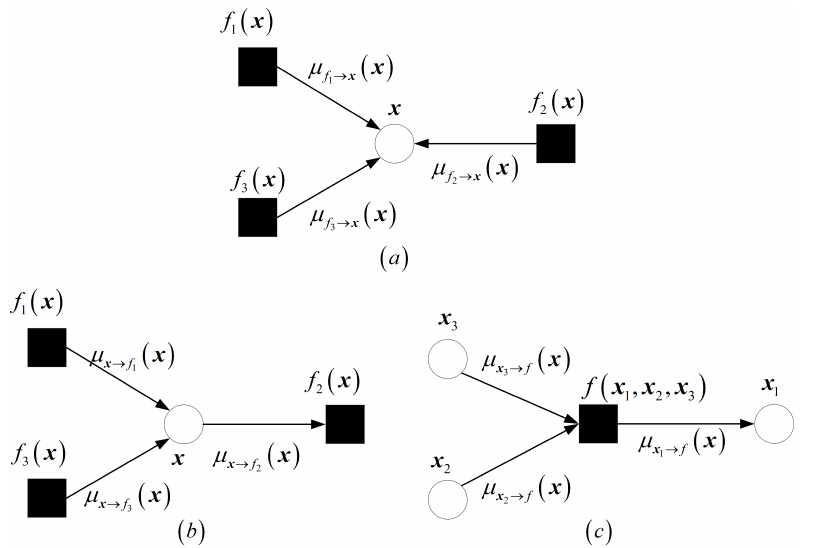
Figure 1. The figure illustrates vector message-passing rules. The circles represent variable nodes and the squares represent factor nodes. µ f → x ( x ) denotes the message from the factor node f to the variable node x and µ x → f ( x ) denotes the message from the variable node x to the factor node f . ( a ) shows the rule of calculating approximate beliefs. ( b ) shows the rule of calculating variable-to- factor messages. ( c ) shows the rule of calculating factor-to-variable